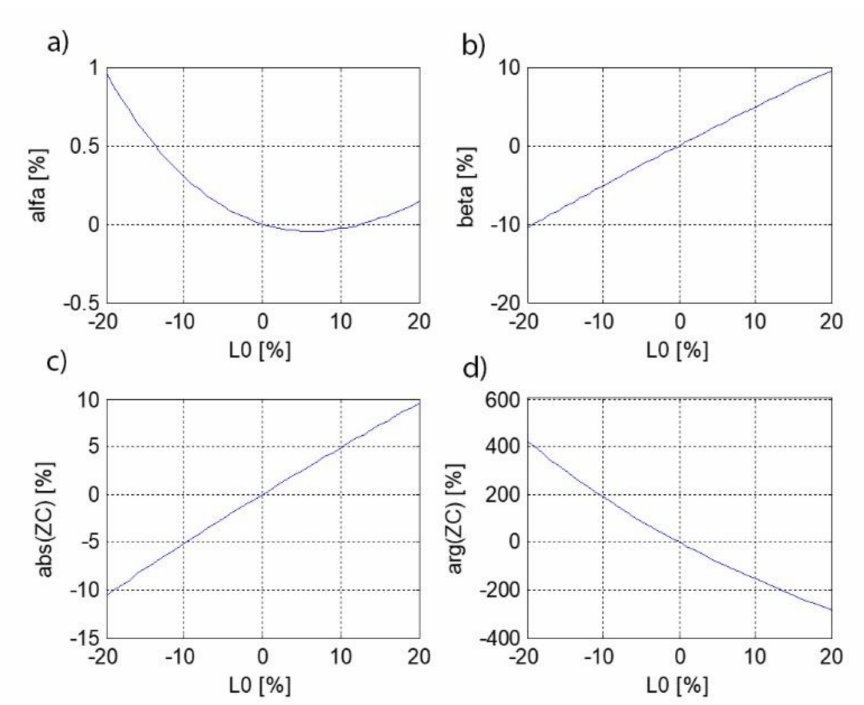
Figure 6. Changes of wave parameters depending on L 0 at f = 500 kHz; ( a ) damping factor α , ( b ) phase factor β , ( c ) wave impedance modulus, and ( d ) wave impedance argument. Changes to the damping factor alpha when changing parameter C 0 are non − linear, and vary from 0.25% to 1.4%, regardless of frequency (Figures 8a, 9a and 10a). The factor β rises almost linearly from − 10% to 10%, regardless of frequency (Figures 8b, 9b and 10b). The impedance modulus rises almost linearly in the range of 12% to − 8% for all tested